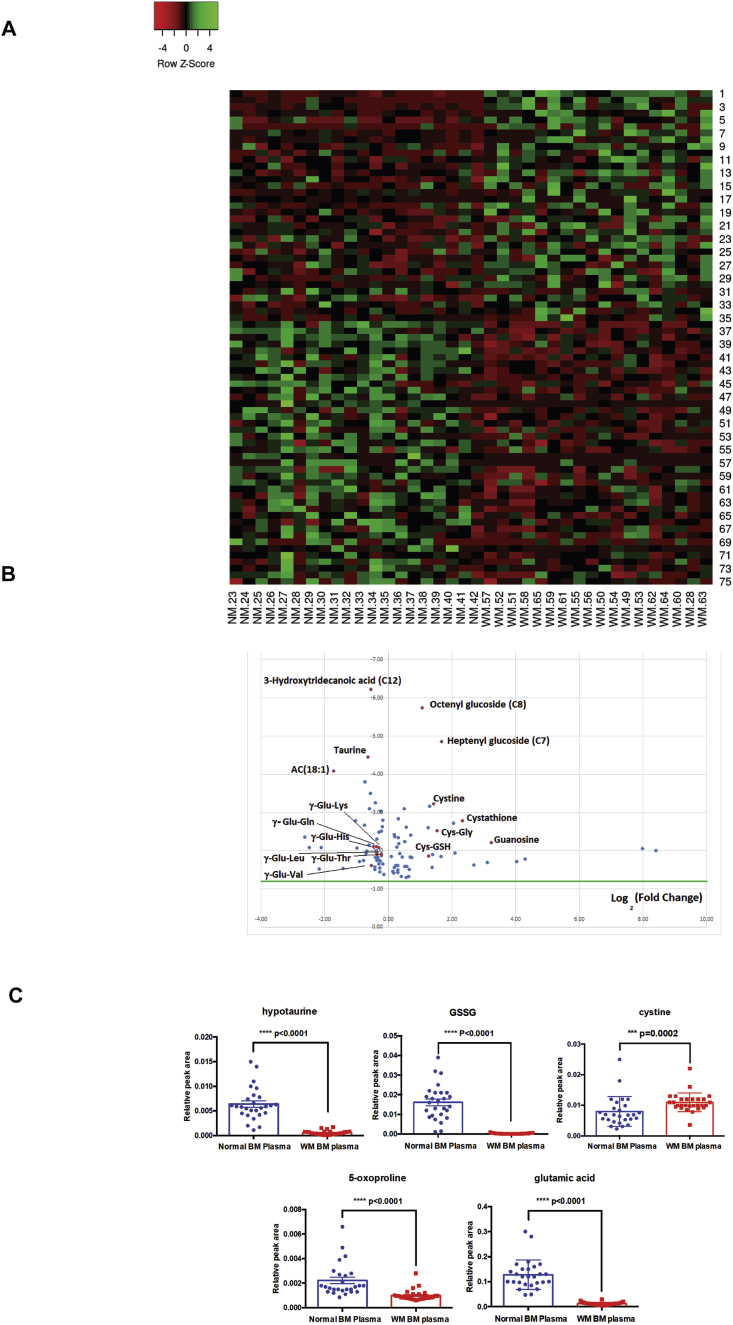
Metabolomic signature of WM patient serum samples as compared to serum from normal donors. A) Heat map analysis showing the differential expression of the metabolites in the WM as compared to normal serum samples. B) Volcano plot of non-WM control serum and WM serum samples based on untargeted metabolomics analysis. Y axis: log 10 (0.05), X-axis: Log 2 (10). C) The comparison of the metabolite levels, those that are relevant to glutathione pathway, in the normal and WM BM plasma samples.